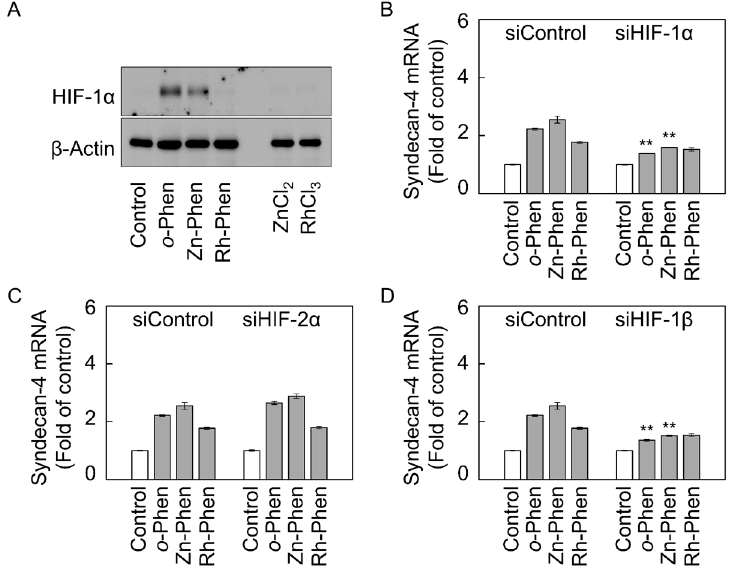
Figure 3. Involvement of hypoxia-inducible factor (HIF)-1 α , HIF-2 α , and HIF-1 β in the induction of syndecan-4 expression by o -Phen, Zn-Phen, and Rh-Phen in vascular endothelial cells. ( A ) Bovine aortic endothelial cells were treated with o -Phen, Zn-Phen, Rh-Phen, ZnCl 2 , or RhCl 3 at 5 µM each at 37 °C for 1 h, and HIF-1 α expression was detected by Western blot analysis; ( B ) Effects of siRNA-mediated knockdown of HIF-1 α on syndecan-4 mRNA levels. Bovine aortic endothelial cells were transfected with siHIF-1 α at 37 °C for 12 h and treated with o -Phen, Zn-Phen, or Rh-Phen at 5 µM each at 37 °C for 8 h; ( C ) Effects of siRNA-mediated knockdown of HIF-2 α on syndecan-4 mRNA levels. Bovine aortic endothelial cells were transfected with siHIF-2 α at 37 °C for 12 h and treated with o -Phen, Zn-Phen, or Rh-Phen at 5 µM each at 37 °C for 8 h; ( D ) Effects of siRNA-mediated knockdown of HIF-1 β on syndecan-4 mRNA levels. Bovine aortic endothelial cells were transfected with siHIF-1 β at 37 °C for 12 h and treated with o -Phen, Zn-Phen, or Rh-Phen at 5 µM each at 37 °C for 8 h. Syndecan-4 mRNA was analyzed by real-time RT-PCR. Values are means ± S.E.M. of four samples. ** p < 0.01 vs. the corresponding siControl.